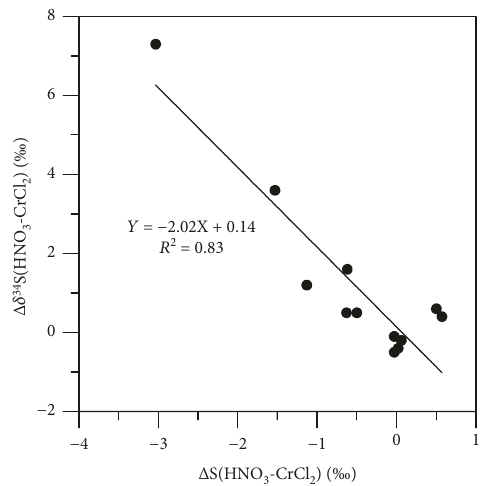
Figure 8: Variation in di ff erences in the sulfur contents ( Δ S) and the di ff erences in the sulfur isotopes ( Δ δ 34 S) of the HNO and CrCl -treated solid bitumen 2